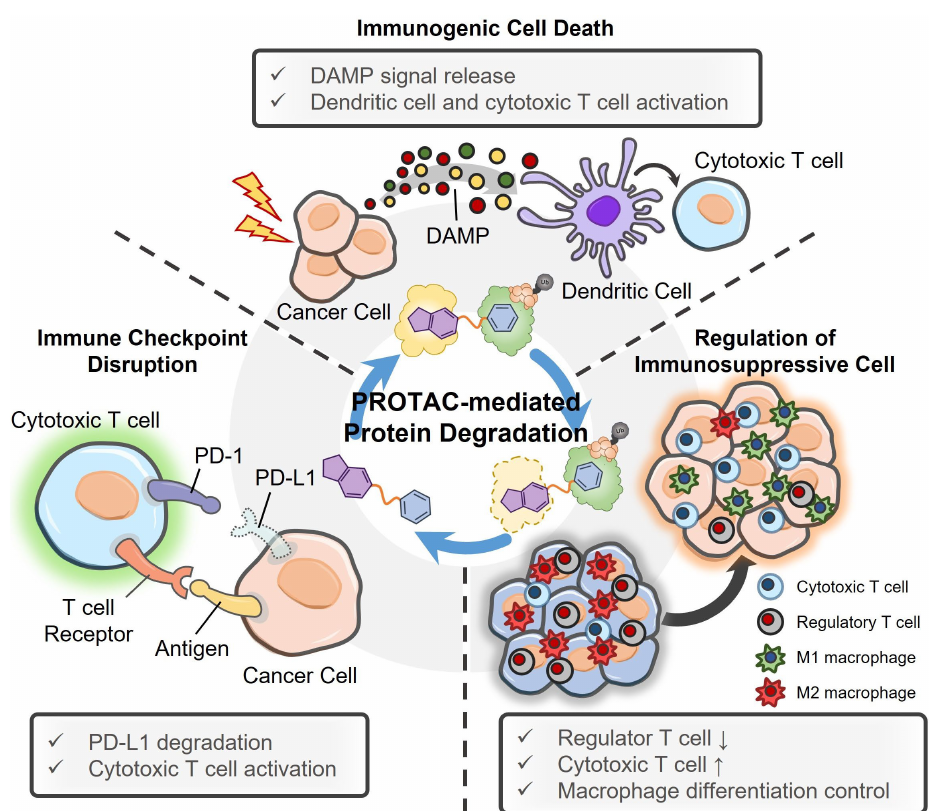
Figure 6. PROTAC-based cancer immunotherapy. The PROTAC treatment can modulate the im- munosuppressive tumor microenvironment to be immunoactive via three pathways. First, PROTACs eliminate oncogenic proteins essential for the growth and survival of cancer cells, causing their immunogenic cell death. Second, PROTACs disrupt the immune checkpoint on cancer cells and make them vulnerable to immune attack by cytotoxic T cells. Finally, PROTACs eradicate immunosuppressive signal-associated cytokines, thereby reducing the population of regulatory immune cells in tumor tissues.